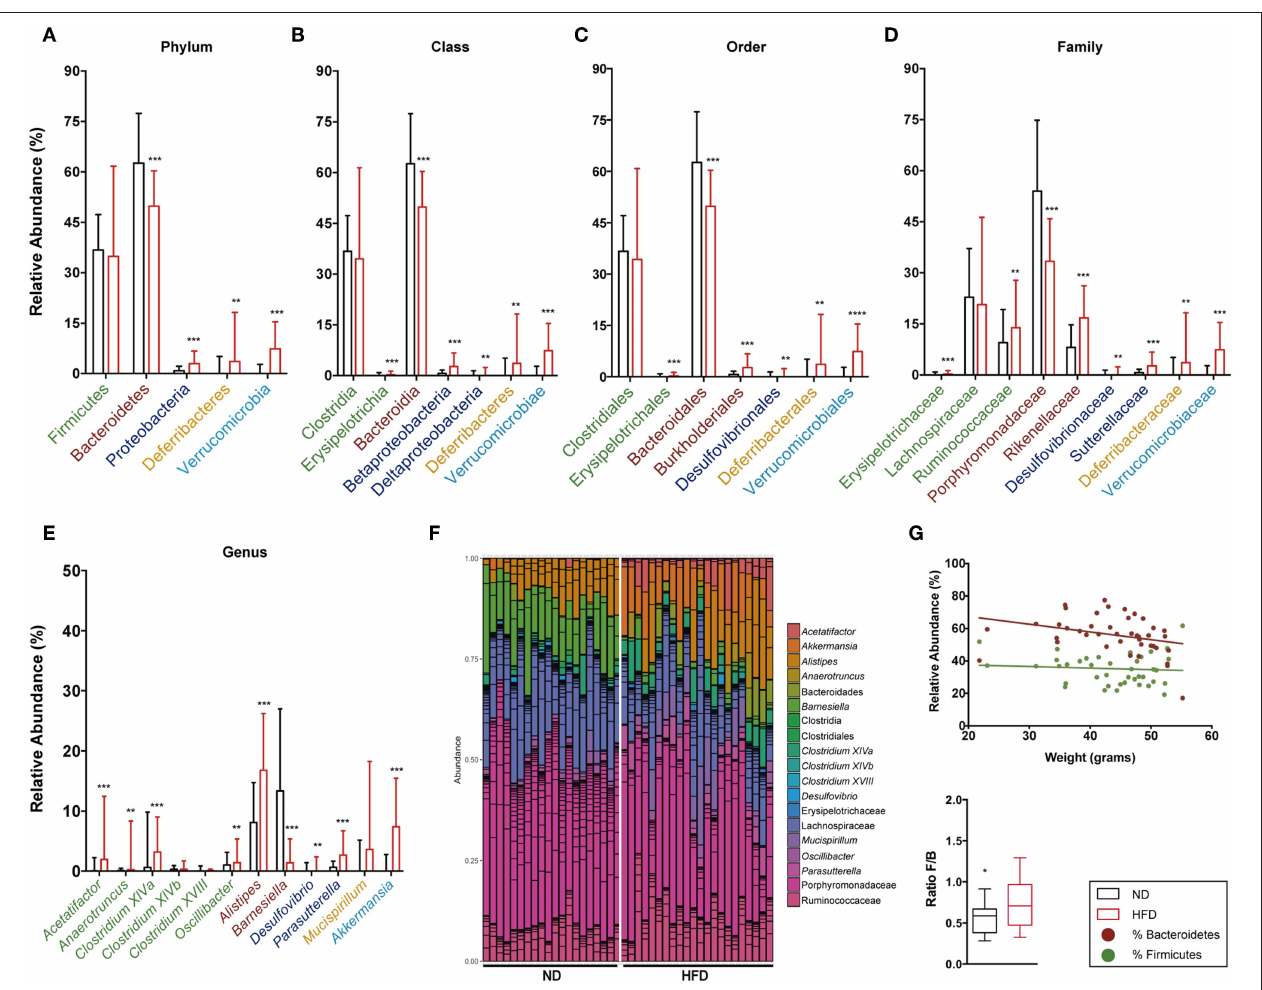
FIGURE 10 | Taxonomic composition of the intestinal microbiota based on 16S rRNA sequencing at week 28 after starting both diets. Analysis of the relative abundance of the most abundant phylum (A) , class (B) , order (C) , family (D) , and genus (E) in ND vs. HFD. (F) Bar plot representation of the OTUs of each sample according the taxonomic classification. (G) Regression plot of Firmicutes and Bacteroidetes phyla against animal weight and analysis of the F/B ratio in ND and HFD. * p < 0.05, ** p < 0.01, *** p < 0.001, **** p < 0.0001; Mann–Whitney